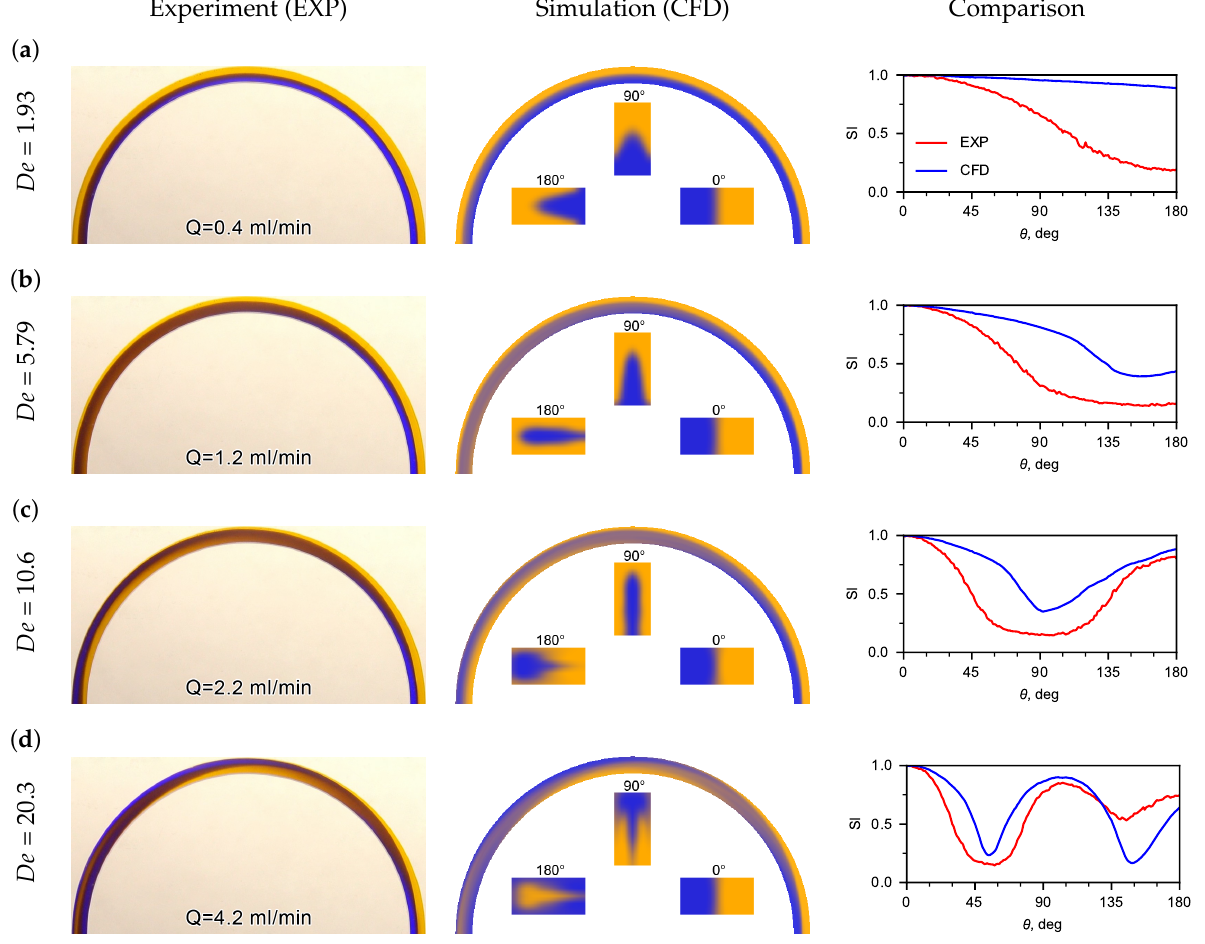
Figure 4. Experimental (left pictures) and calculated (CFD) (center pictures) flow patterns for water at different De numbers. On the right pictures are the distributions of SI depending on the angle θ (the red line is the experiment, the blue line is the CFD). The inserts in the calculated flow patterns are the phase distribution contours in sections 0 ◦ , 90 ◦ , and 180 ◦ , which clearly display the secondary Dean flow in the U-microchannel. ( a ) flow patterns for water at De =1.93; ( b ) flow patterns for water at De =5.79; ( c ) flow patterns for water at De =10.6; ( d ) flow patterns for water at De